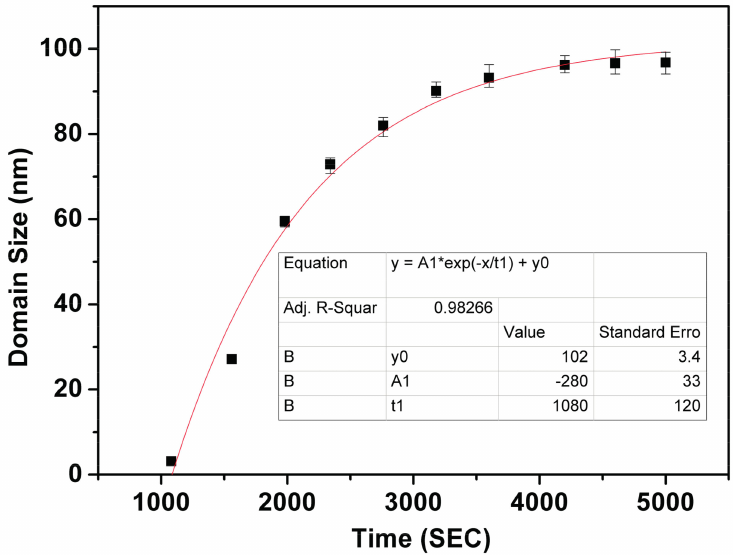
Figure 5. The relationship of domain size with time increasing in the poled area of Figure